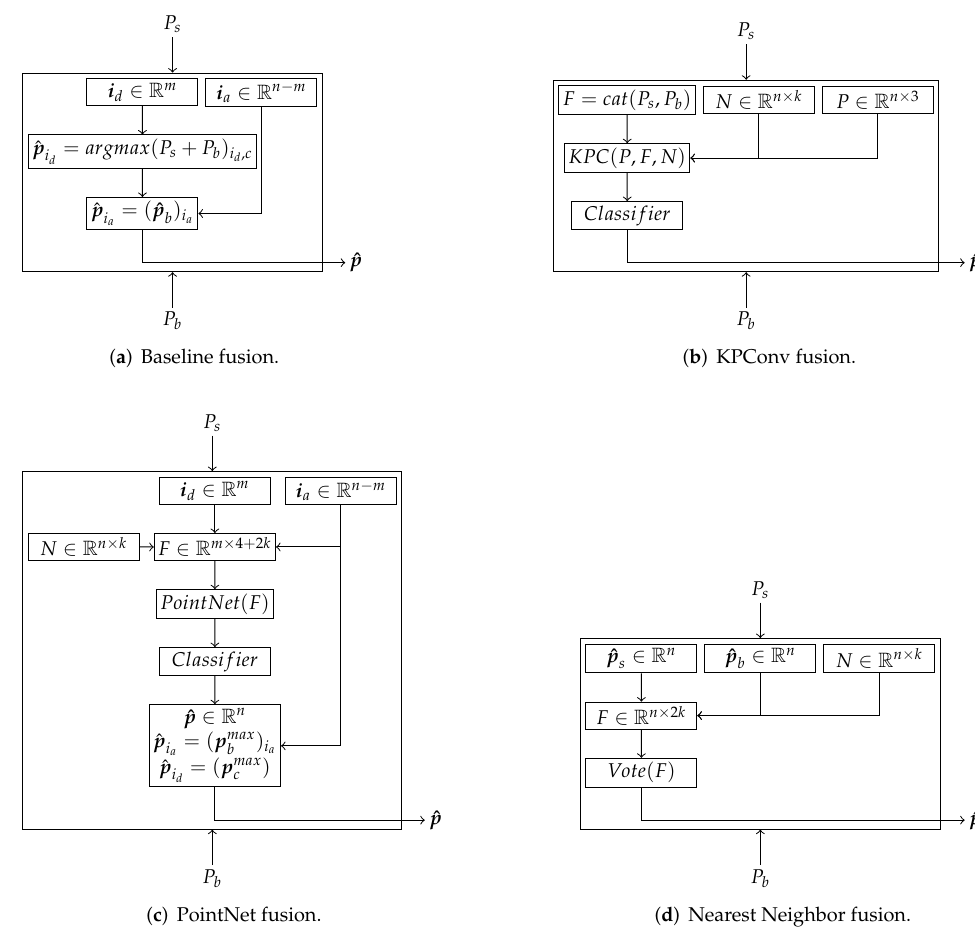
Figure 4. Different fusion approaches illustrated. Within the baseline ( a ) predictions, where both branches agree, are accepted directly. The probabilities for belonging to a class are added, and the class with the highest value is assigned in case of mismatched predictions. KPConv fusion ( b ) uses the NN, the point coordinates, as well as the predictions as features to learn the fusion. PointNet fusion ( c ) works similar, but works only on disagreeing points, and for the fusion process, a small PointNet network is used. Within the NN fusion ( d ), a consensus vote is performed over the NN and both predictions. All but ( a ) make use of the point